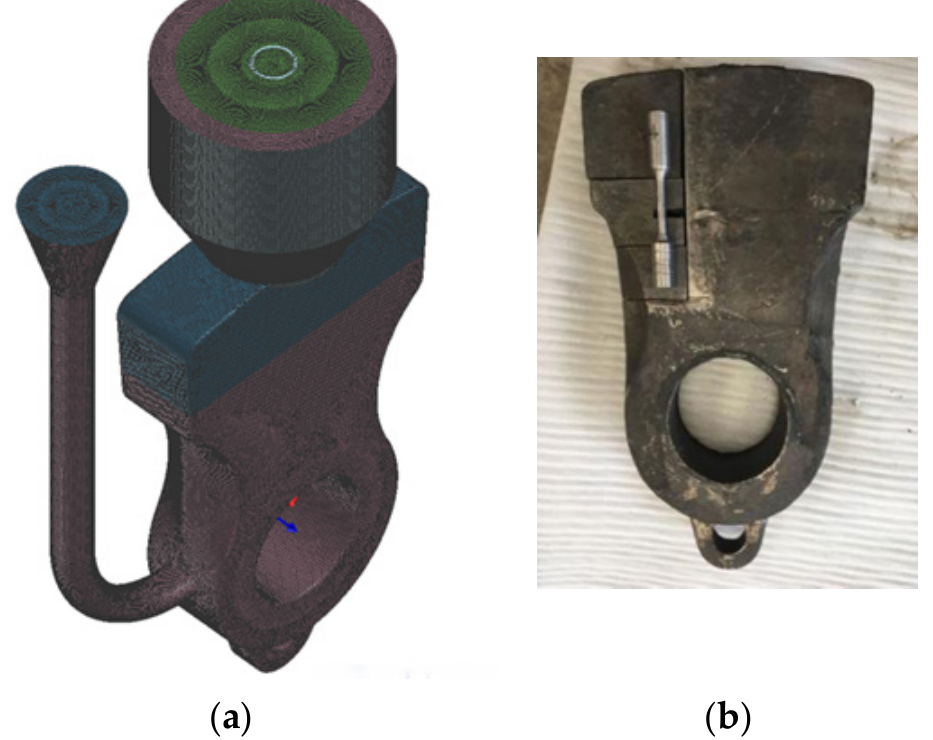
Figure 2. ( a ) Horizontal–vertical casting modeling, and ( b ) a typical bimetallic hammerhead.